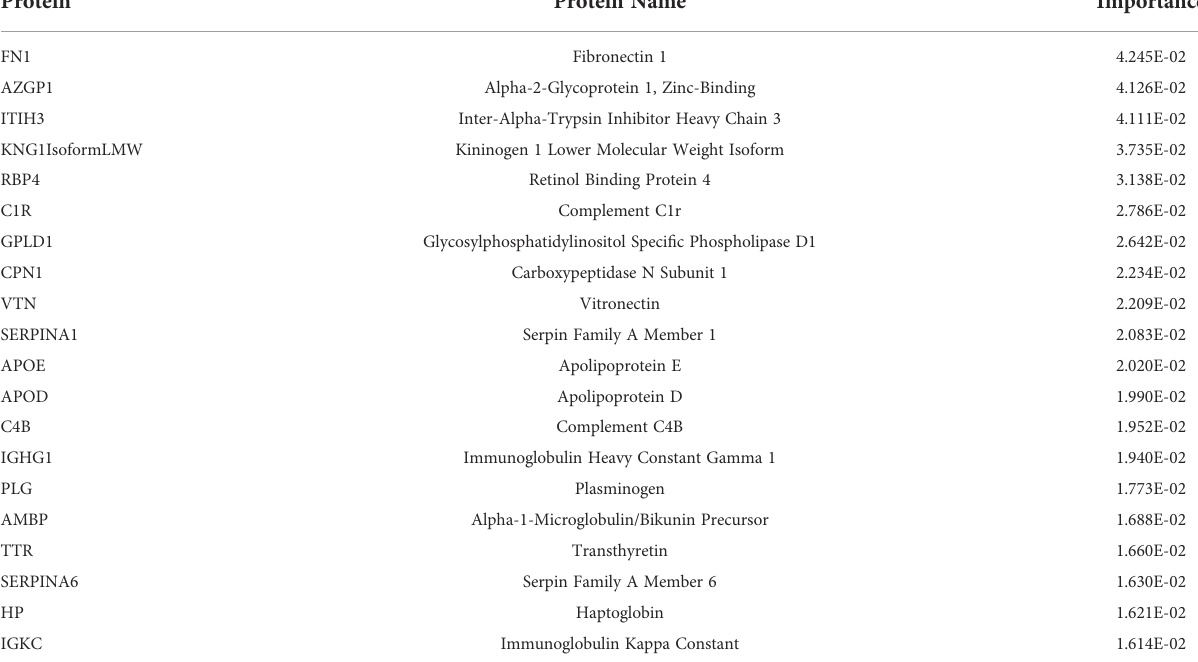
TABLE 6 Proteins distinguishing LD and WNV.